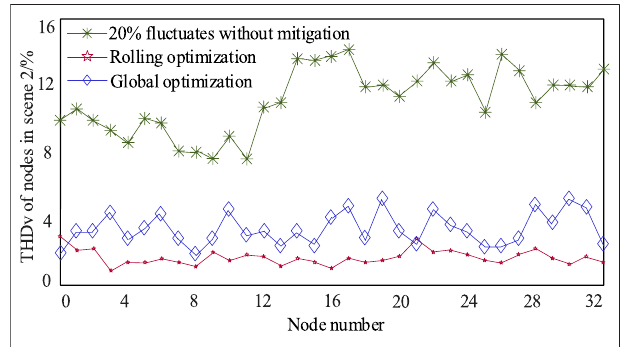
FIGURE 2 | Total voltage distortion rate of each node before and after mitigation under scenario 1.